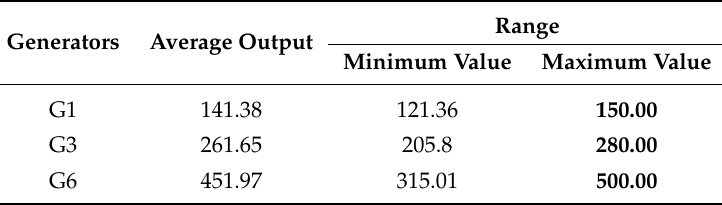
Table 6. Power output from generators in case 2 (MW).